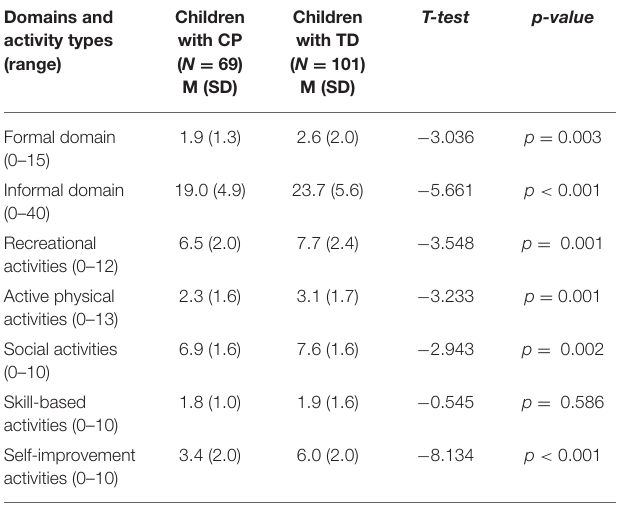
TABLE 2 | Comparison of CAPE diversity scores between CP and TD